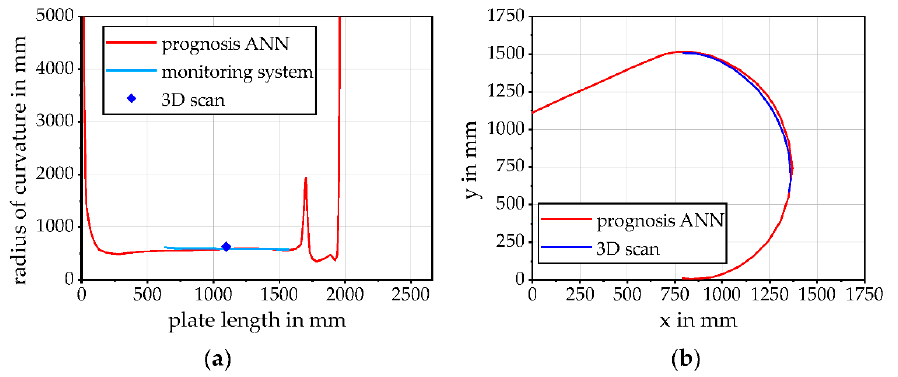
Figure 8. ( a ) Comparison of the ANN prognosis with the measurements of the forming result. ( b ) Geometric comparison of the ANN prognosis with the point cloud of the 3D scan.